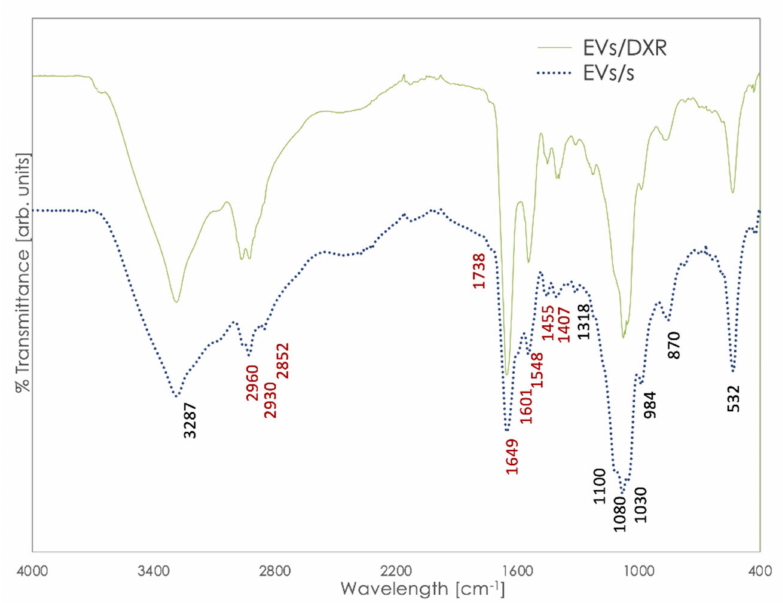
Figure 2. Representative spectra of EVs/s and EVs/DXR after subtracting PBS curve. Bands in red are those relevant to lipids and proteins structure, experiencing differences among different